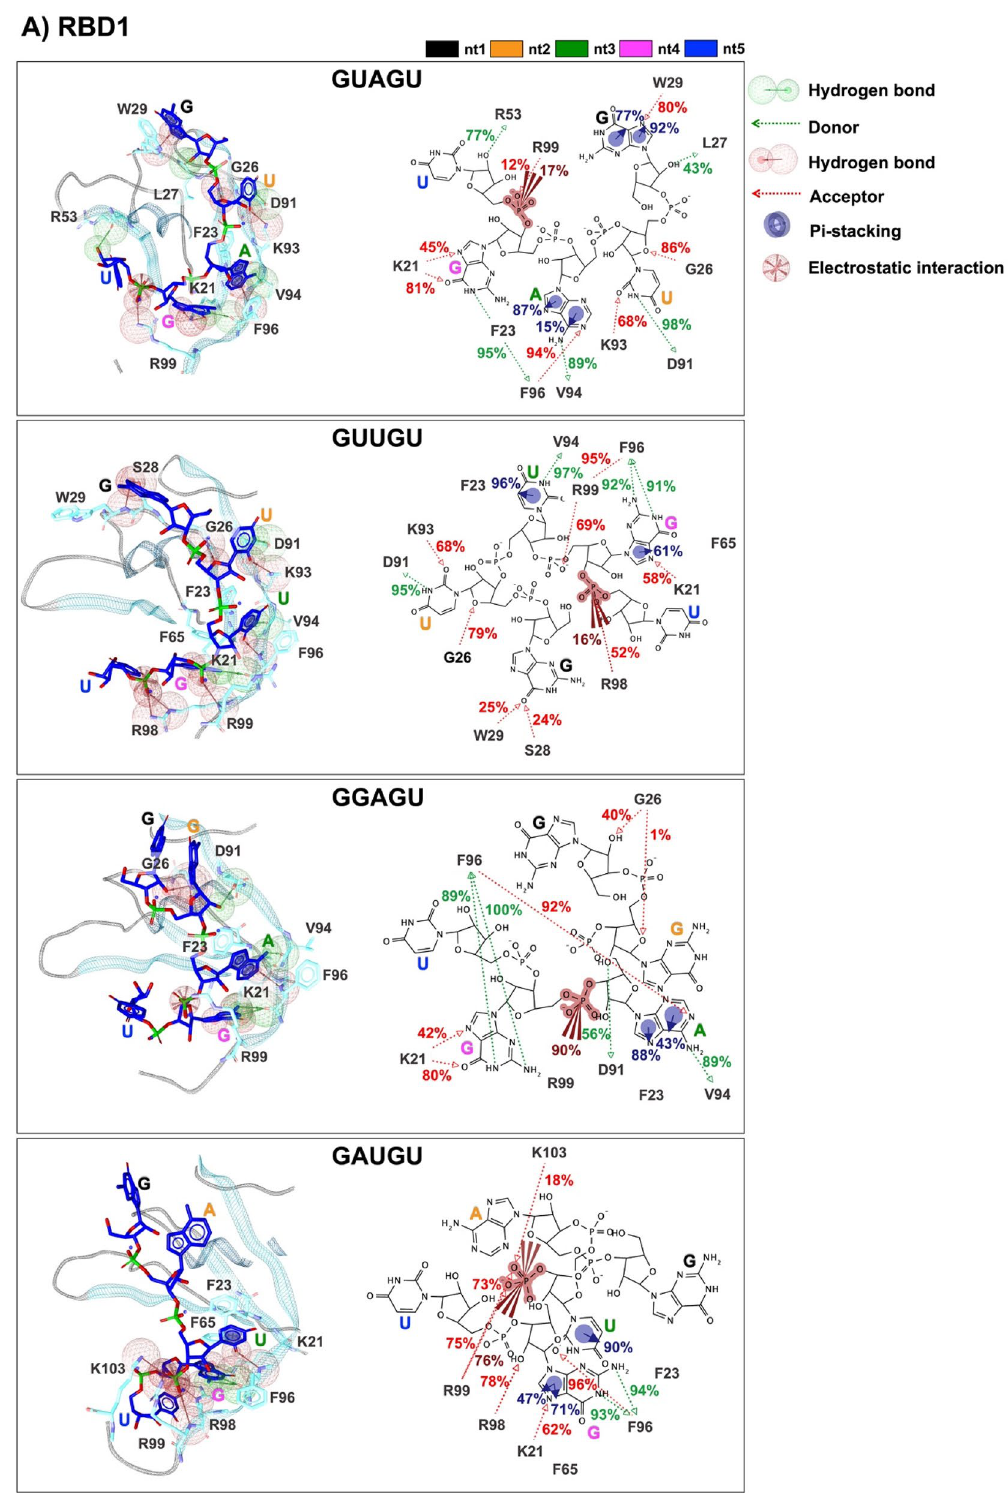
Figure 6. Pharmacophore models and protein–RNA interaction maps with percentage of occurrence in the last 20 ns of ( A ) MSI1–RBD1 and ( B ) MSI1–RBD2 in complex with the four RNA pentamers GUAGU, GUUGU, GGAGU, and GAUGU. Pi–pi interactions are highlighted by blue circles, electrostatic interactions are highlighted by red spheres, and hydrogen bond properties are highlighted by green/red spheres and